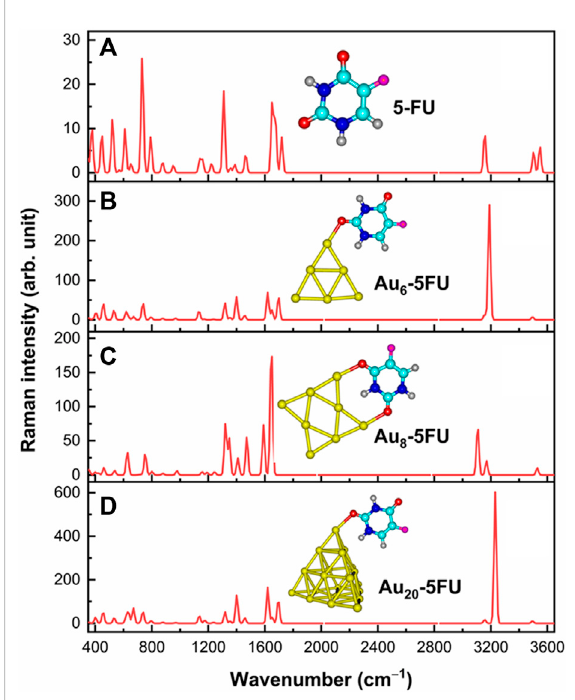
FIGURE 8 Raman signatures of5FU (A) and its SERS spectra on Au N (N= 6, 8, 20) surfaces (B – D) in aqueous